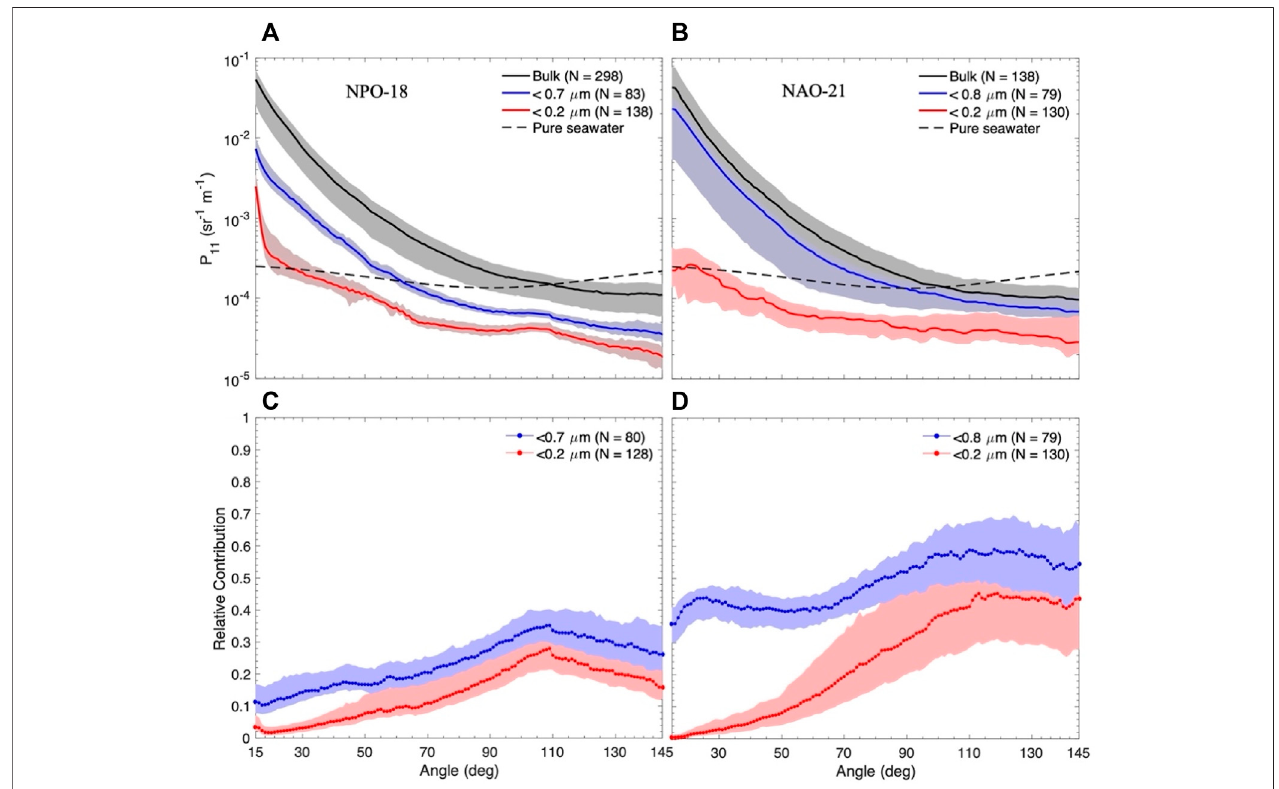
FIGURE2| ThemedianvaluesofparticulateP 11 measured bytheLISST-VSFforun fi lteredsample(Bulk),0.7- μ m fi ltrate( < 0.7 μ m),and0.2- μ m fi ltrate( < 0.2 μ m)in the (A) NPO-18and (B) NAO-21sitesandtherelativecontributionbysubmicronparticlesinthe (C) NPO-18and (D) NAO-21sites.Theshadedarearepresentsthe25th and 75th percentile of the data. Theoretical pure seawater scattering (black dash line) was calculated using the Zhang et al. (2009) model.